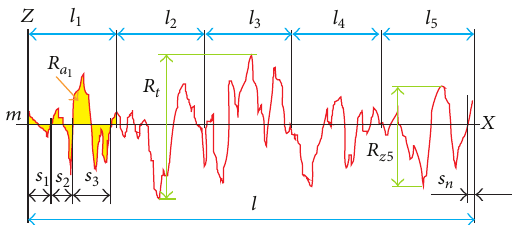
Figure 3: Parameters 𝑅 𝑎 ,𝑅 𝑡 ,𝑅 𝑧5 , 𝑆 𝑚 with the centre line 𝑚 .